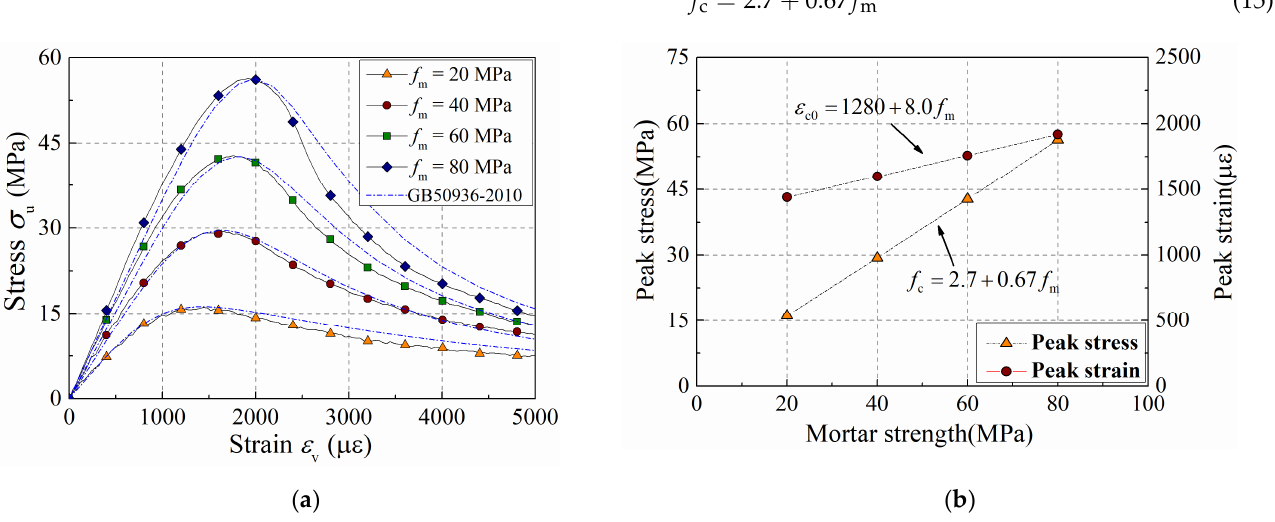
Figure 3. Mechanical properties of concrete specimens with varying mortar strengths: ( a ) stress–strain curve; ( b ) peak values.